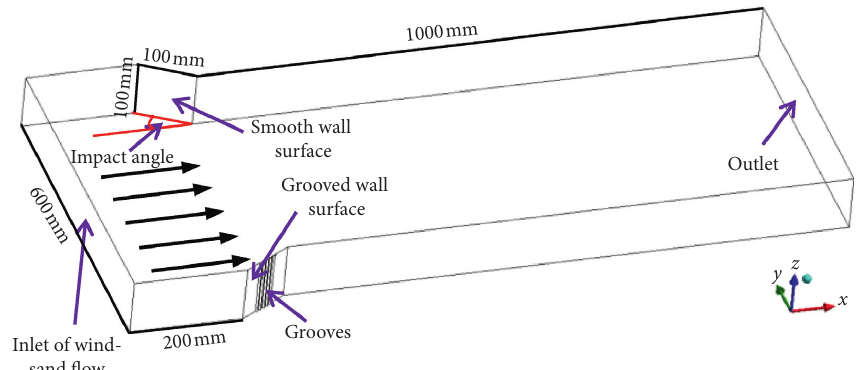
Figure 2: Schematic diagram of the computational domain. The black arrows indicate the sand particle path.